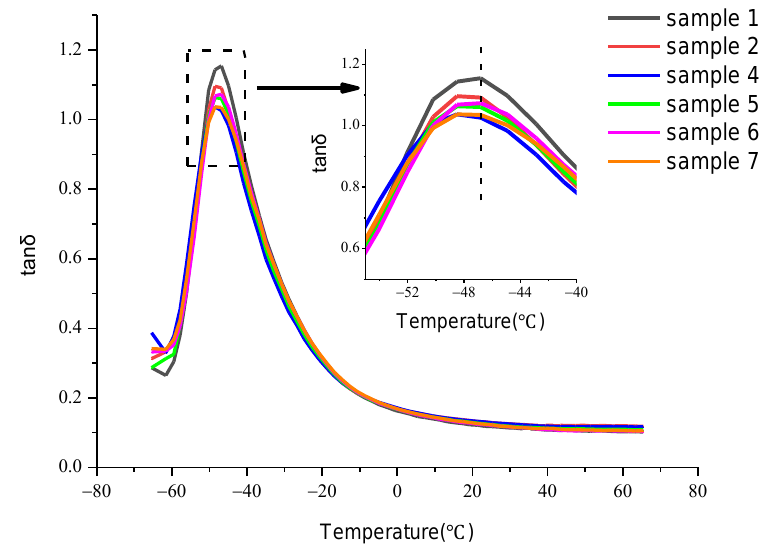
Figure 6. Relationship between the tan δ of the CNT/WPRP/NR composite and Figure 6. R elationship between the tanδ of the CNT/WPRP/NR composite and temperature .